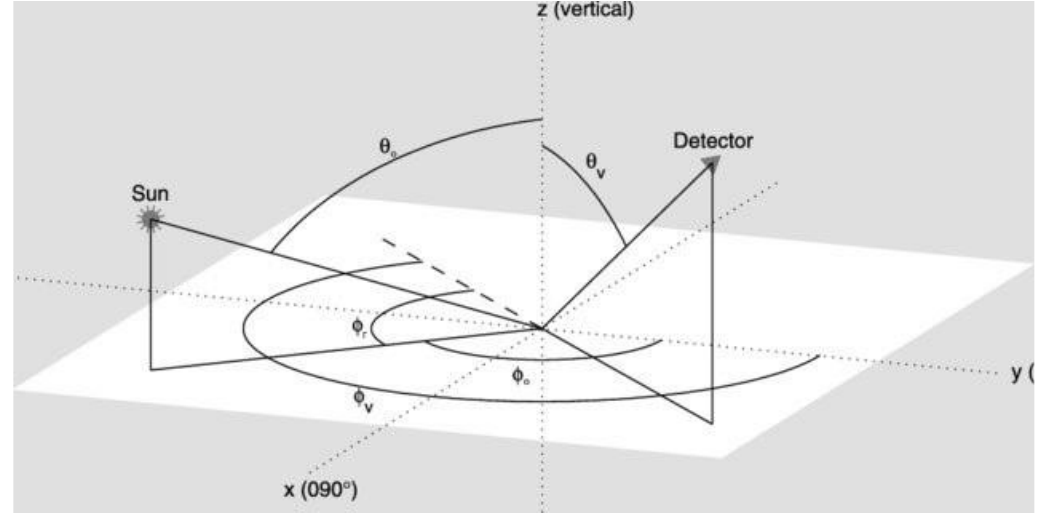
Figure 1. Definition of the solar zenith angle 𝜃 𝟎 , solar azimuthal angle 𝜙 𝟎 , viewing zenith angle 𝜃 𝒗 , viewing zenith angle 𝜙 𝒗 and relative azimuth angle 𝜙 𝒓 . Illustration after Hudson et al. (2006). [16]